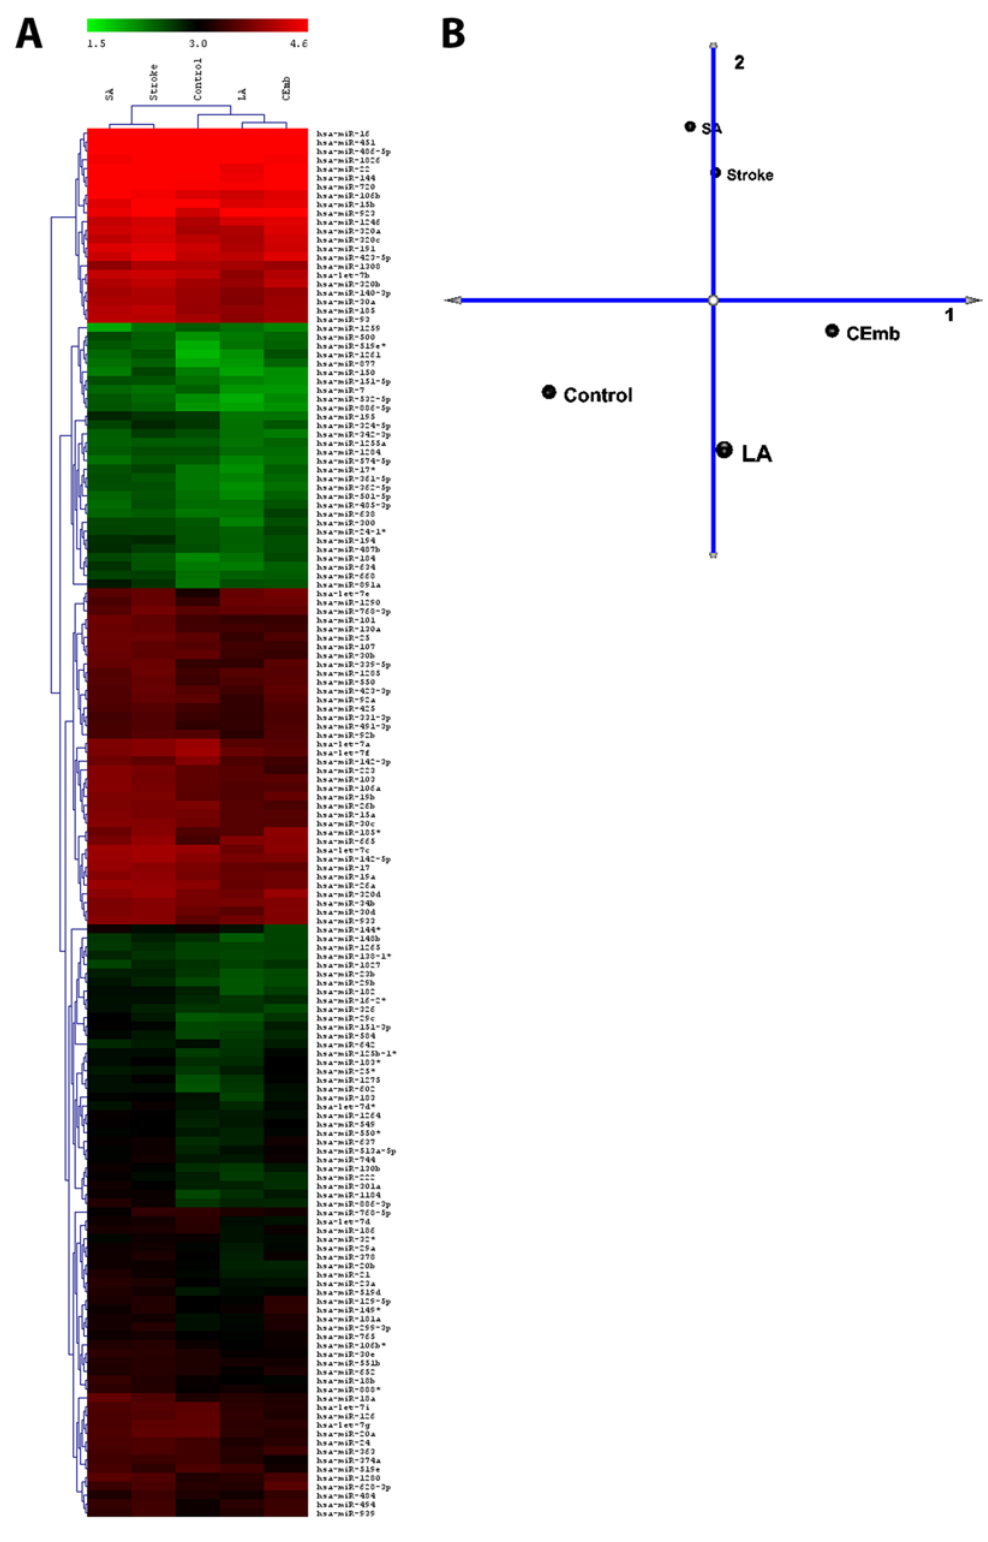
Figure 1. microRNA profile data. ((a)) MicroRNA profiles: For normal control, all stroke samples pooled (stroke, n=19), small artery (SA, n=3), large artery (LA, n=8) and cardioembolic (CEmb, n=5) stroke. The hierachical clustering was carried out for both the samples as well as the miRNAs. The average signal intensities for each significantly expressed miRNA (one way ANOVA, p value , 0.05) was log10 transformed and the values have been used for the construction the tree. (b) . Principal Component Analysis (PCA) were carried out on the same set of data. The hierachical clustering and PCA were constructed using the using the TM4 software [29].